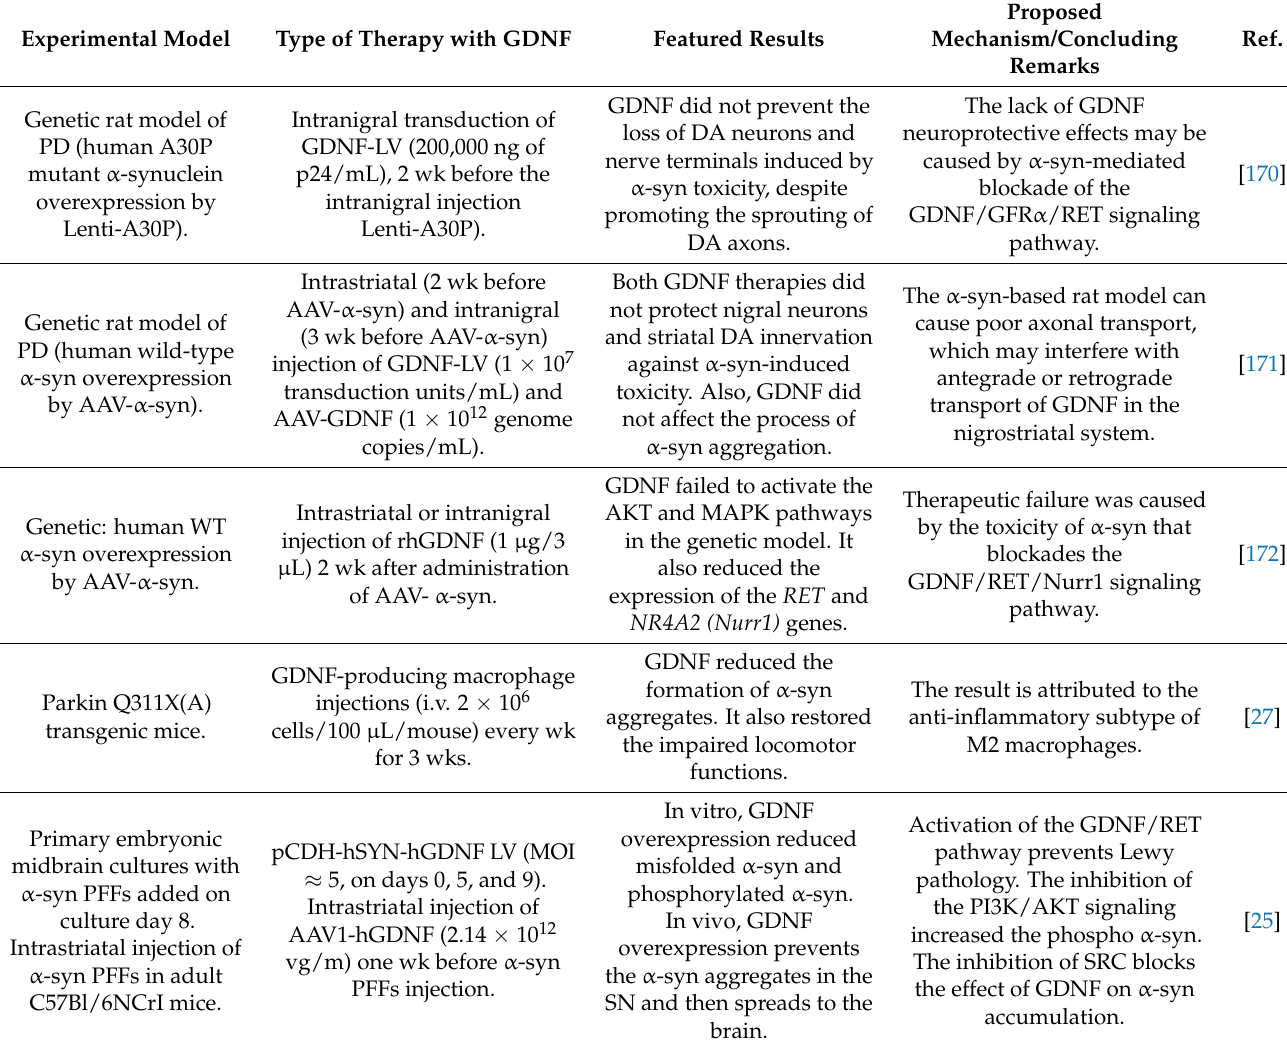
Table 3. GDNF therapy against α -syn pathology in preclinical trials of